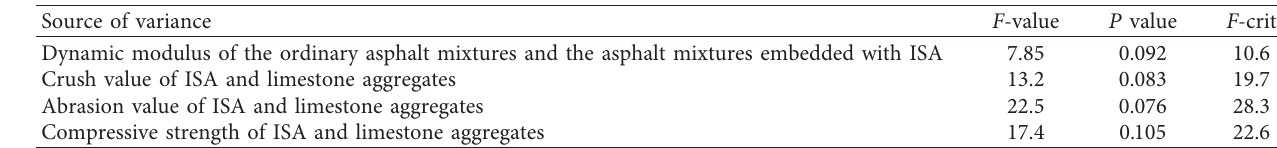
Figure 11: Comparison of dynamic modulus test results. (a) Test specimens. (b) Test result of dynamic modulus. (c) The state of the ISA after test Table 7: Difference analysis of test results.